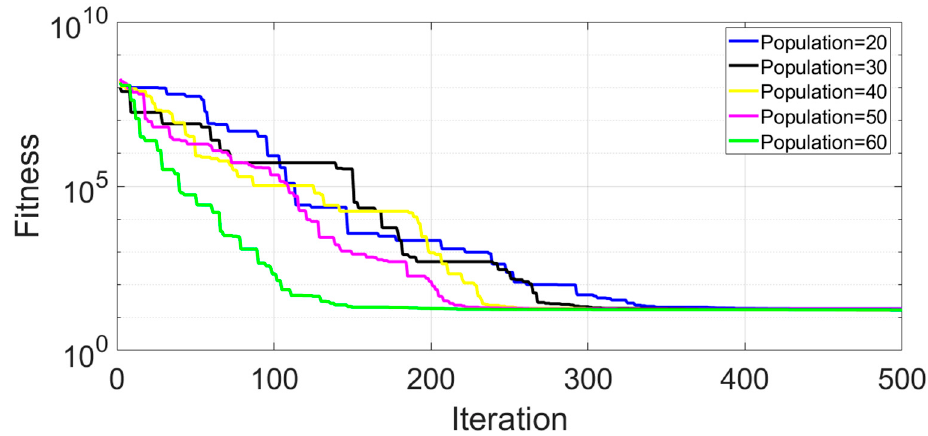
Figure 8. Comparison of parametric results with different numbers of search agents in the HMSCACSA.